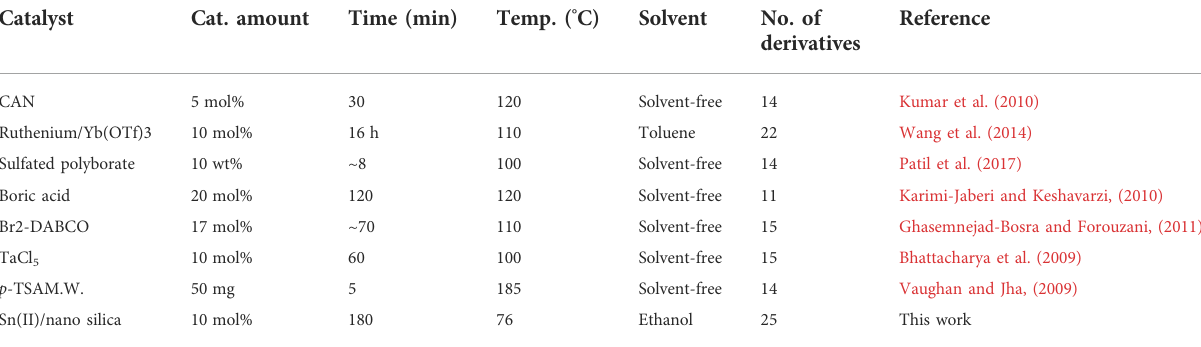
TABLE 3 Brief comparison between the present study and previous reports. Catalyst